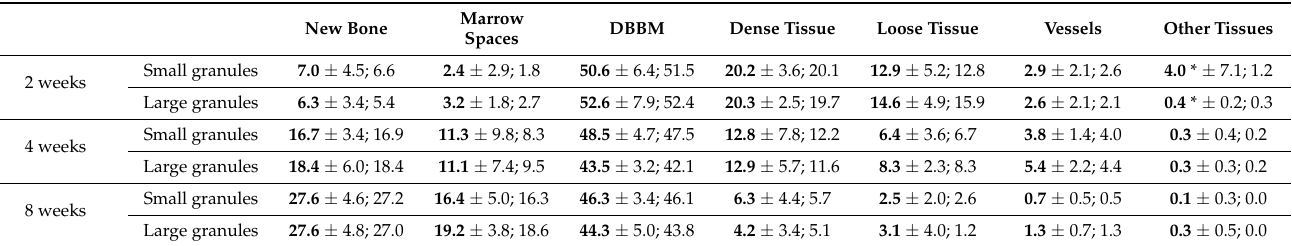
Table 2. Tissues in contact with the DBBM surface in the three periods of evaluation. Mean values (in bold) ± standard deviations; median in percentages.